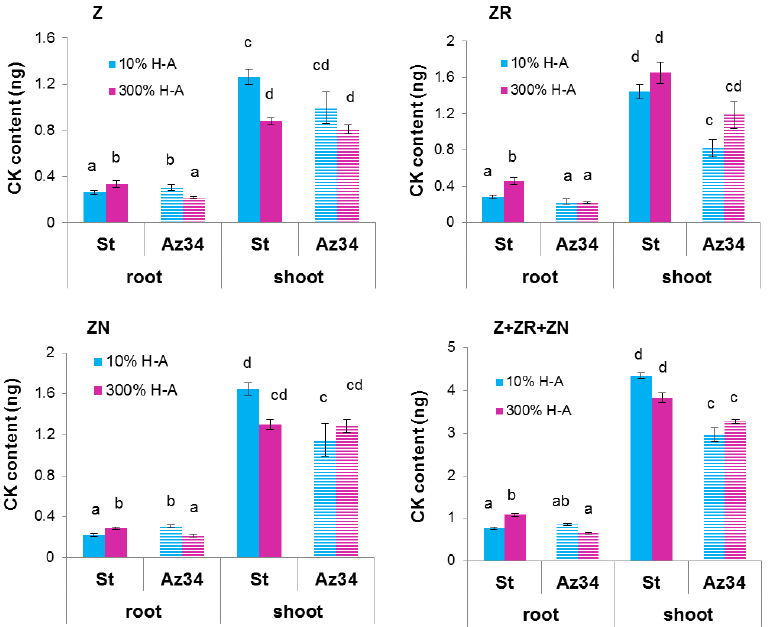
Figure 3. Content of zeatin (Z), zeatin riboside (ZR), zeatin nucleotide (ZN) and their sum (Z + ZR + ZN) in roots and shoots of 6-day-old barley wild type (Steptoe) and its ABA-deficient mutant (Az34) growing at 10% of supra-optimal (300%) Hoagland-Arnon solution (H-A). Means ± SE are presented. Statistically different means (n = 9) are indicated by different letters ( p < 0.05, ANOVA, Duncan’s test).